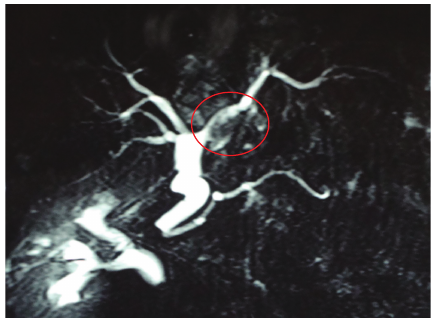
Figure 2: MRCP showing a filling defect in the left hepatic duct.